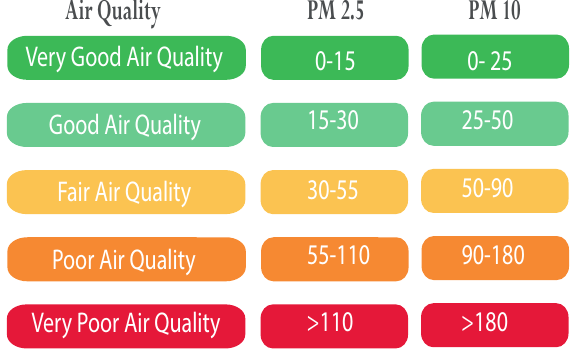
Figure 9. European air quality Index (PM 10 and PM 2.5 in µ g/m 3